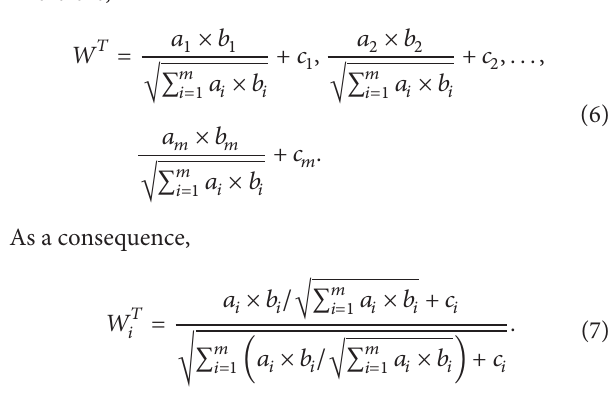
Figure 3. (2) Fuzzy Mean Value and Variance . Fuzzy number has two kinds of distribution, uniform distribution and proportional distribution. We can define the respective fuzzy mean 𝑚(𝛼) and variance 𝜎(𝛼) as